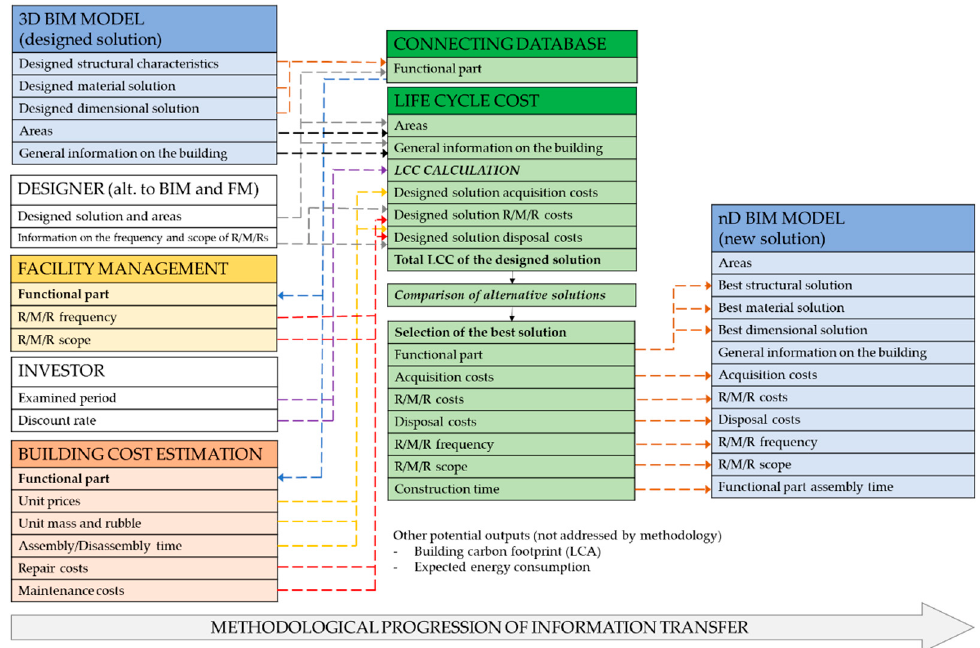
Figure 1. The process of exchanging information among the individual systems to ensure the best material solution of the building.